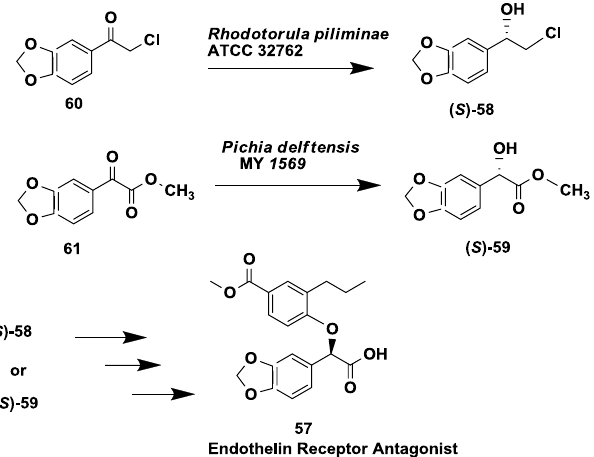
Figure 15. Endothelin receptor antagonist: Enantioselective microbial reduction of keto ester and chloroketone.